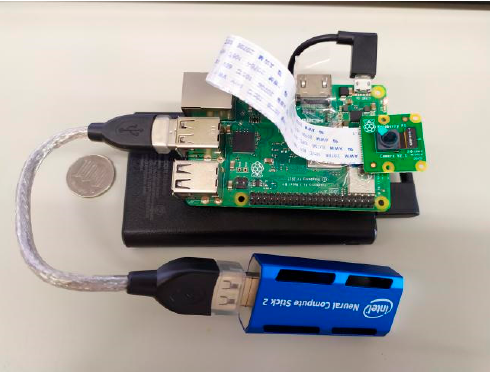
Figure 2. Constructure of real-time detection sub-device.